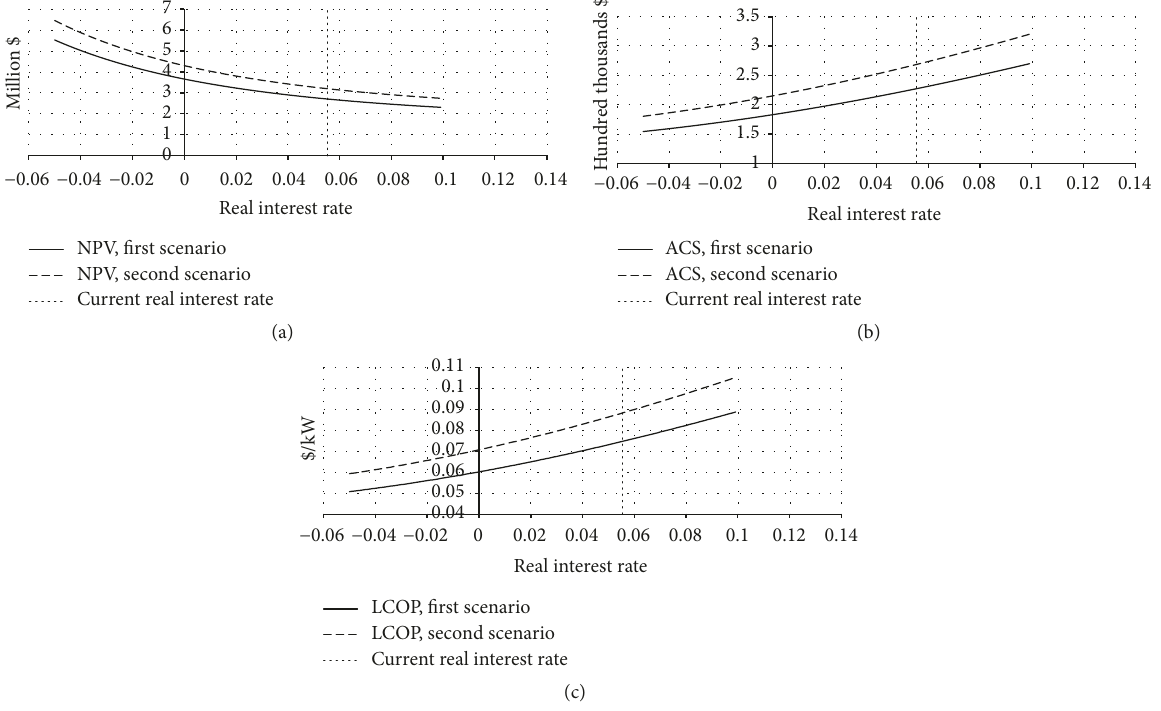
Figure 10: Variation of (a) NPV, (b) ACS, and (c) LCOP versus real interest rate.